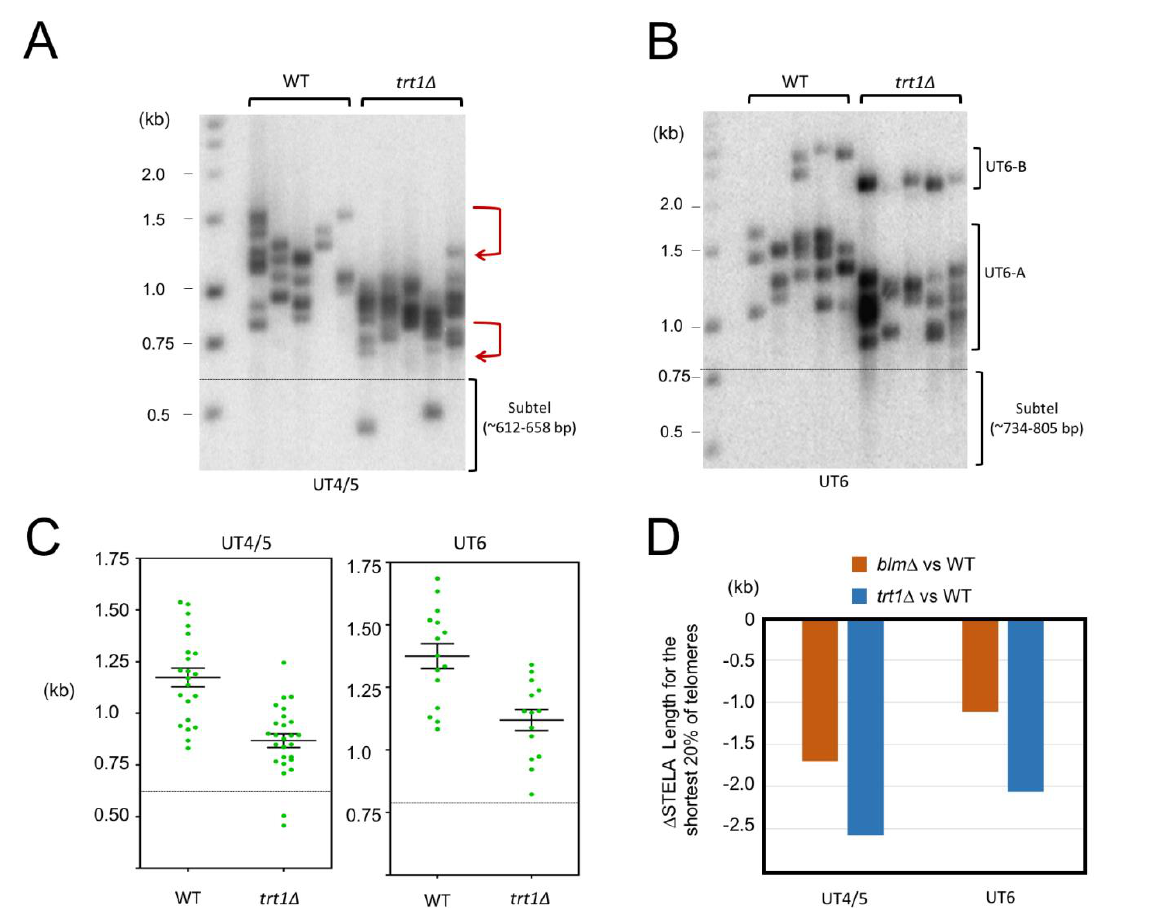
FIGURE 4: STELA comparison of telomeres in the wild type and trt1 ∆ strains. (A) UT4/5 STELA assays were performed in parallel using wild type and trt1 ∆ DNA. (B) UT6 STELA assays were performed in parallel using wild type and trt1 ∆ DNA. (C) The STELA products in 4A and 4B were analyzed using the TESLA software, and the results plotted. Error bars designate standard errors of mean. (D) The average lengths for the shortest 20% of the telomeres in the STELA analysis were determined for the wild type, blm ∆ , and trt1 ∆ samples, and the differ- ences between the wild type and mutants